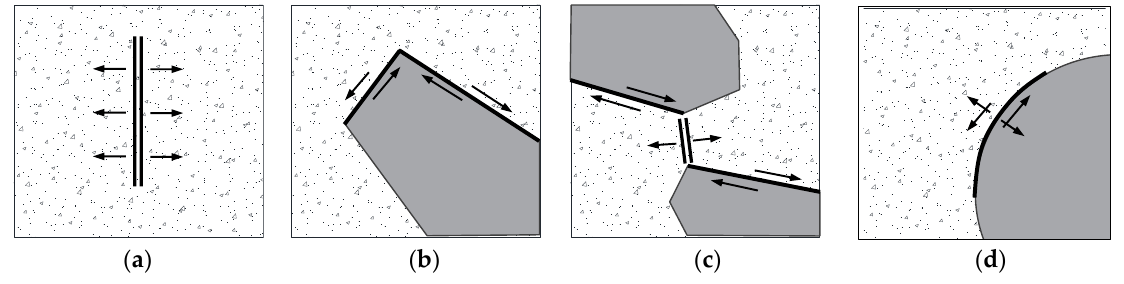
Figure 20. Schematic diagram of different cracking modes: ( a ) compression induced tensile crack; ( b ) shear crack; ( c ) shear induced tensile crack; ( d ) mixed crack.